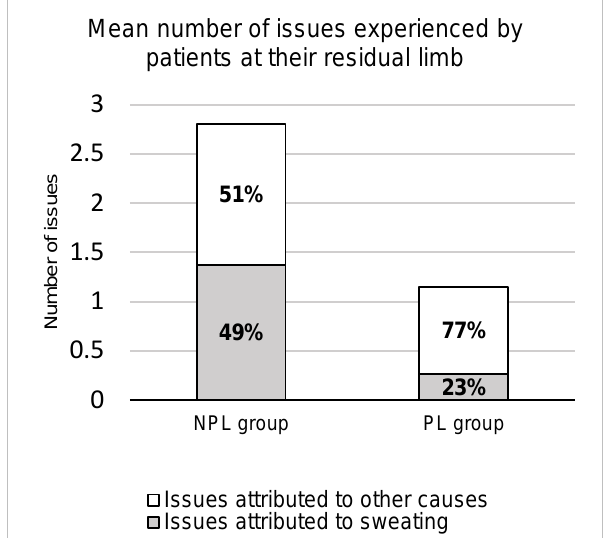
Figure 6: The mean number of issues experienced by patients at their residual limb, and the percentage of those issues that were attributed to sweating (grey) or to other causes (green). Exact percentages are indicated within bars.